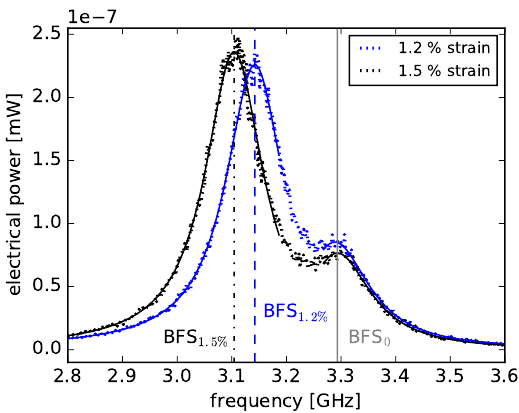
Figure 5. BGSs of a 200 m PFGI-POF with applied strain values of 1.2% and 1.5% in the first 90 m, measured by an electrical spectrum analyzer. The regression functions of the strained and non-strain fiber segments are shown as well as their corresponding